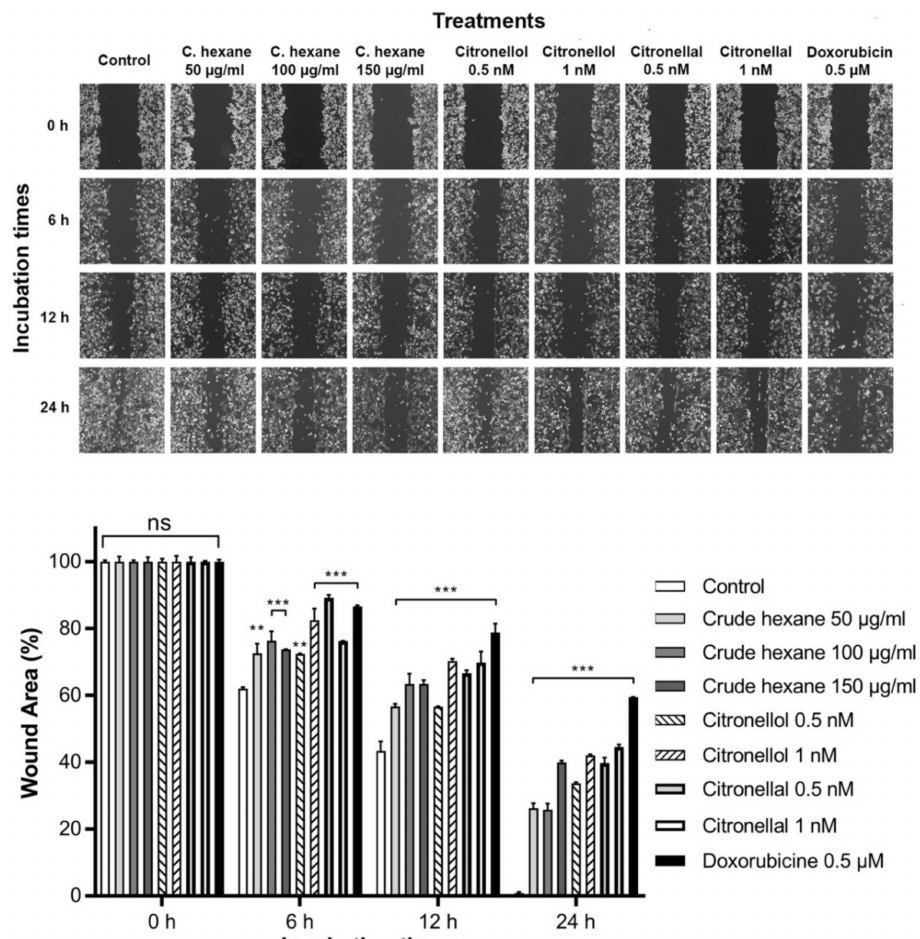
Figure 3. Cells migration into wound areas was observed under microscope at 6 h, 12 h, and 24 h. ImageJ 1.52a software was used to analyze cells migration into wound areas. Data are presented as means ± SEM. One-way ANOVA with Dunnett’s multiple comparisons test was used to analyze the di ff erence between control and treatment groups, p value < 0.05 considered significant (** p < 0.01, *** p <